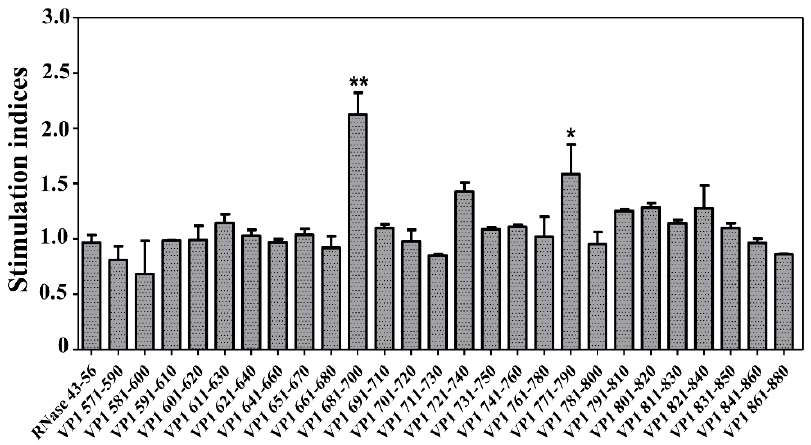
Figure 1. Proliferative responses to the overlapping peptides of VP1 in CVB3-infected animals. A / J mice were infected with CVB3, and at termination on day 21 post-infection, splenocytes were prepared. Cells were stimulated with or without the overlapping peptides of VP1 or control (RNase 43–56) for 2 days, and after pulsing with 3 [H] thymidine for 16 h, proliferative responses were measured as cpm. Stimulation indices were derived by dividing the cpm values of peptide-stimulated cells (100 µ g / mL) by those of medium control. Representative data set obtained from three individual experiments, each involving 10 to 12 mice are shown. * p ≤ 0.05, and ** p ≤ 0.01.